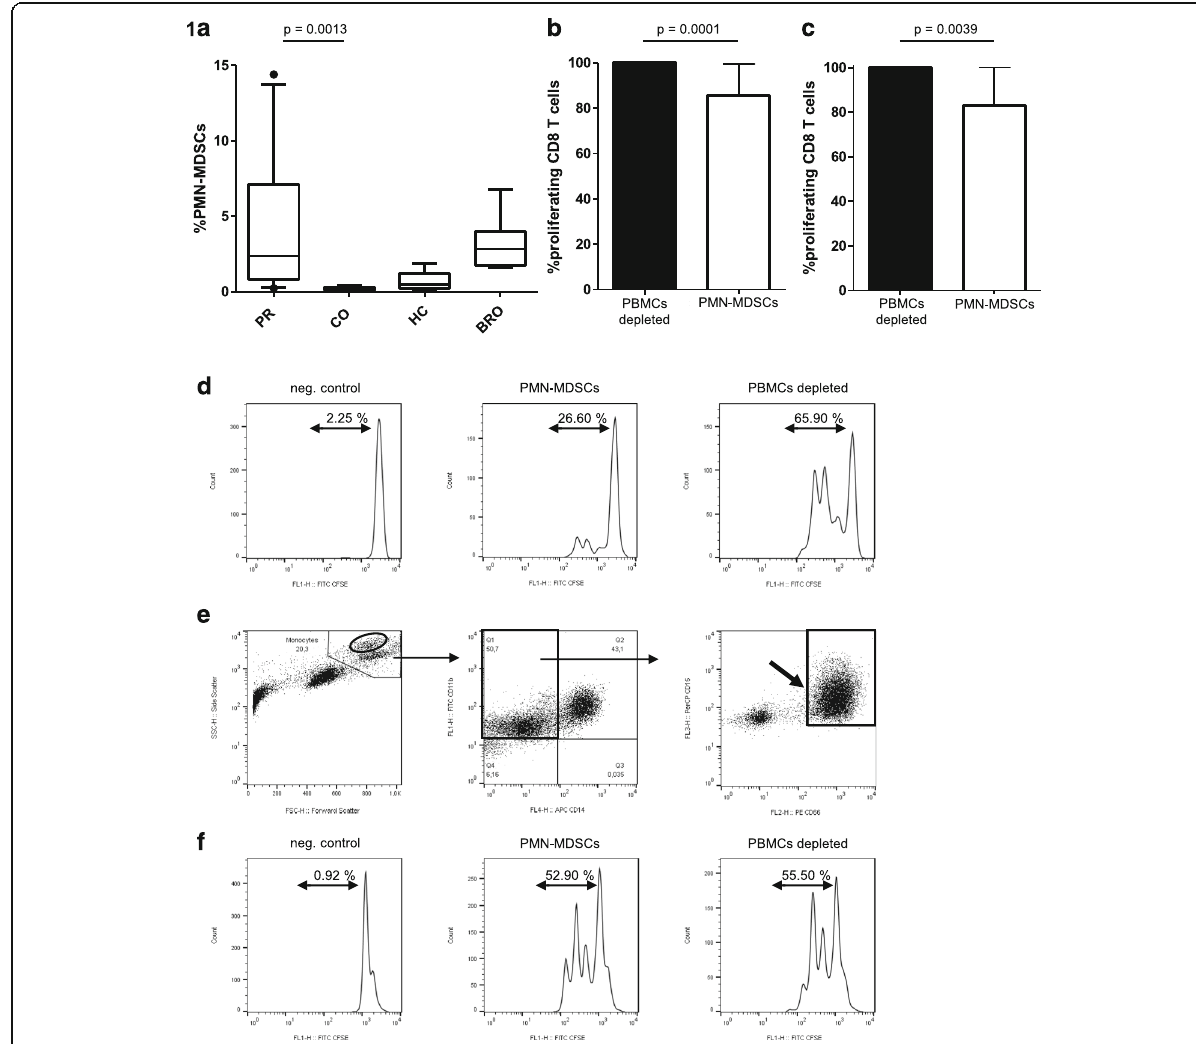
Fig. 1 Frequencies, suppressive function and gating strategy of PMN-MDSCs. a Progressors (PR) showed significantly higher PMN-MDSC frequencies than controllers (CO) ( p = 0.0013), but there was no difference in the frequencies between PR patients and patients with lung carcinoma (BRO) ( p = 0.87). ( b + c ) Significantly decreased percentages of proliferating CD8 T cells after coincubation with PMN-MDSCs